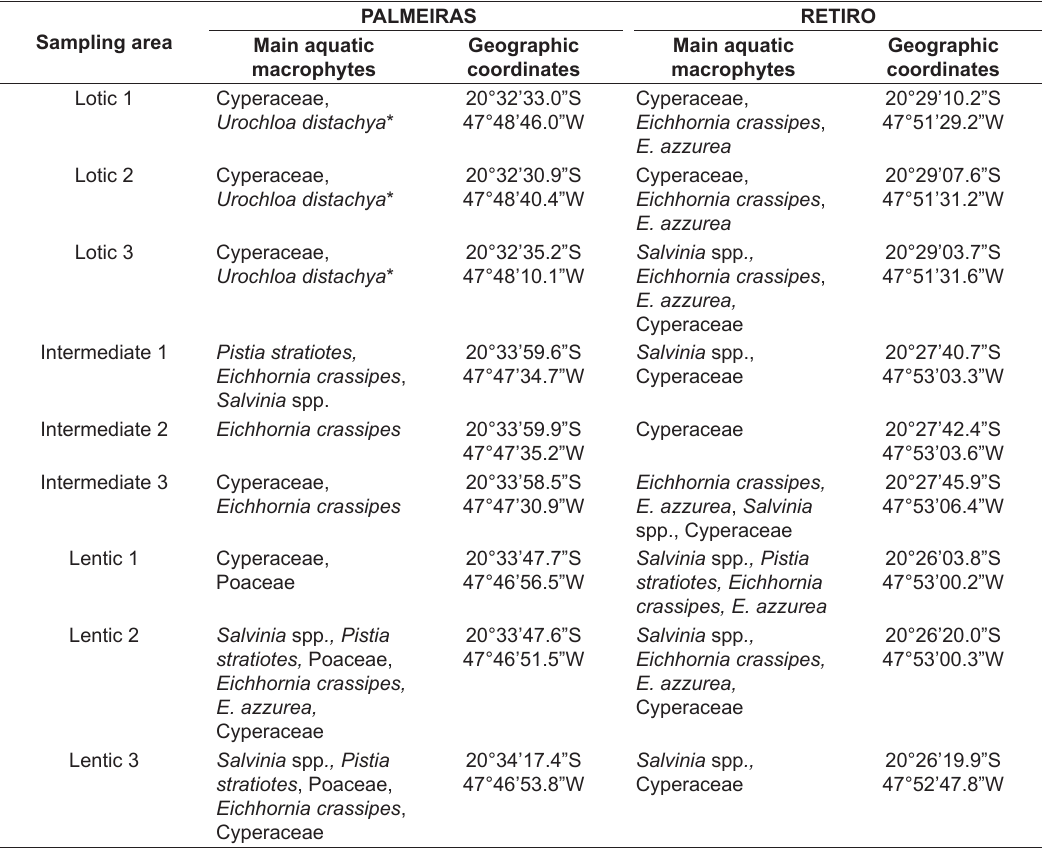
Table 1. The main aquatic macrophytes present and the sampling points geographic coordinates in Palmeiras and Retiro reservoirs, Sapucaí-Mirim River (SP) (*exotic